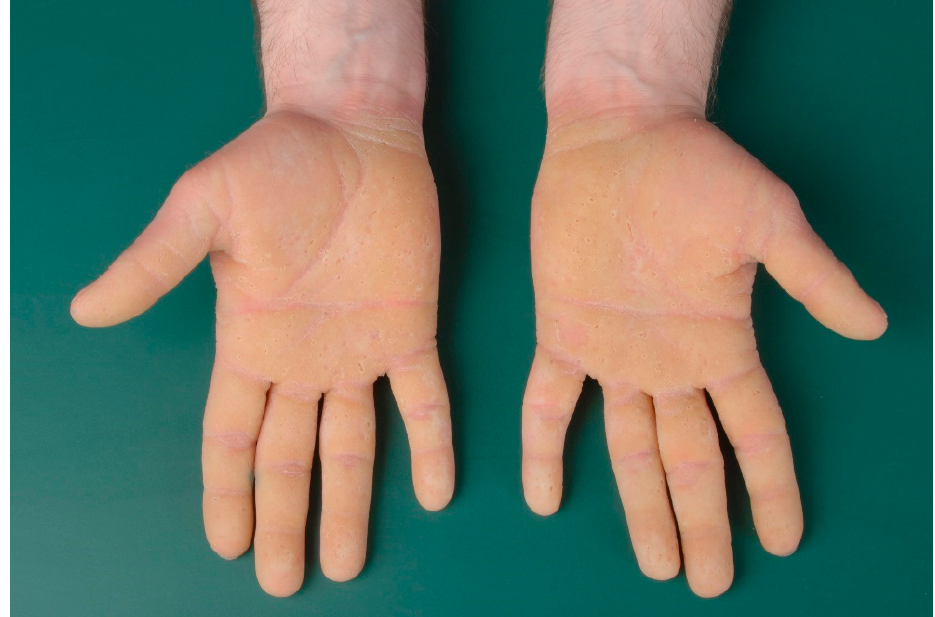
Figure 5. Epidermolytic ichthyosis. Diffuse palmoplantar keratoderma ( keratin 1 mutation).